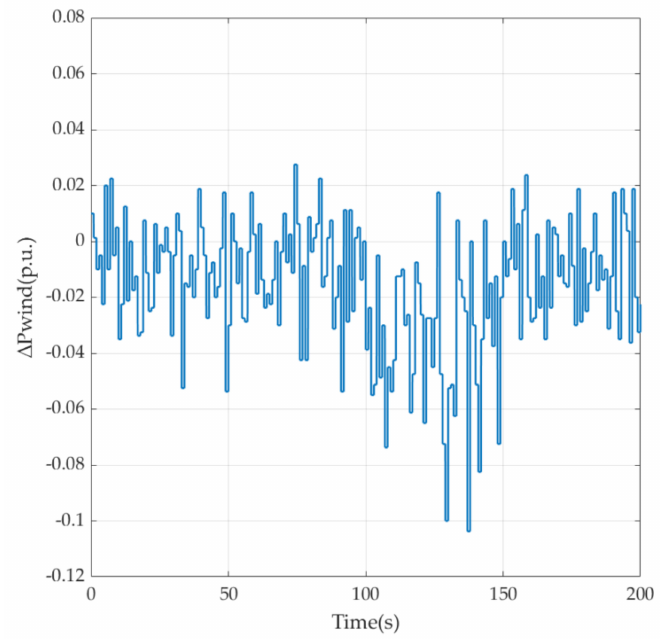
Figure 18. Continuous wind power fluctuations.